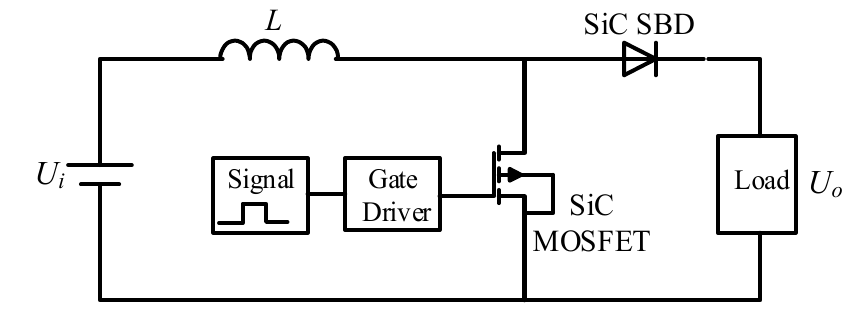
Figure 14. A topology of the boost DC–DC converter